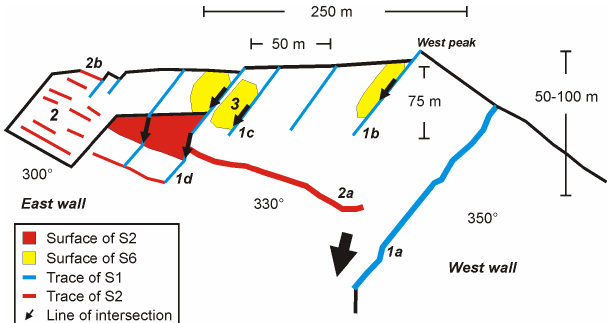
Figure 11. Sketch showing two scales of wedge-shaped blocks at the crest of the rock slope at Adeane Point. Wedges formed by S1– S6 have dimensions of 50–75m. The large wedge formed by S1– S2 has dimensions of about 75 and 250m. Azimuths are the dip directions of the rock slope at the respective